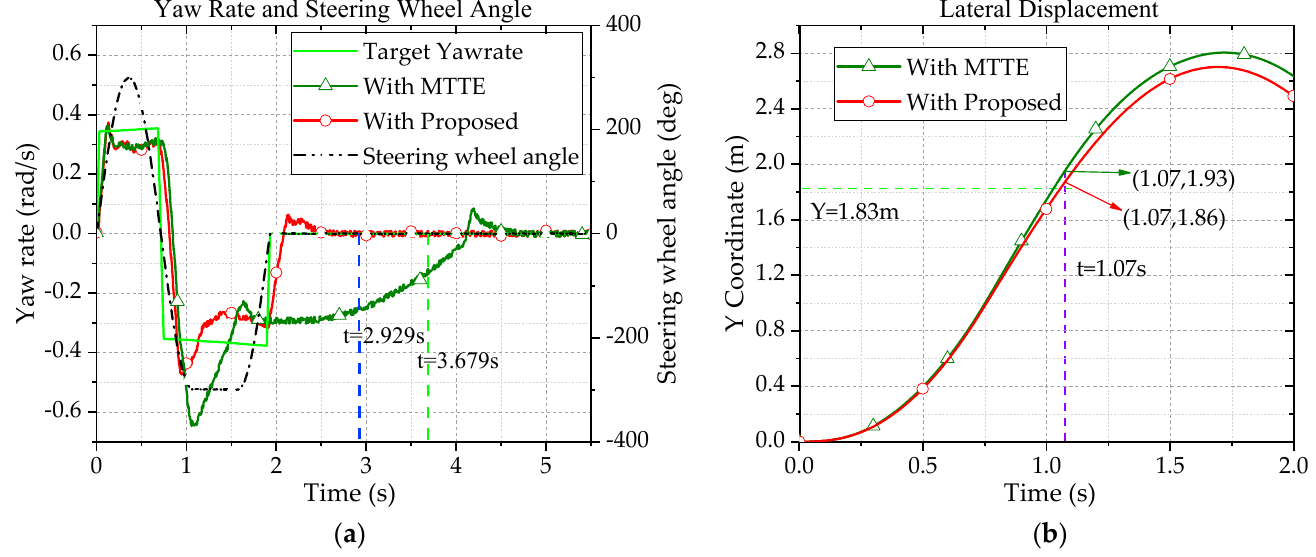
Figure 8. Sine with dwell simulation results on a high-adhesion road: ( a ) the yaw rate and steering wheel angle; ( b ) lateral displacement.